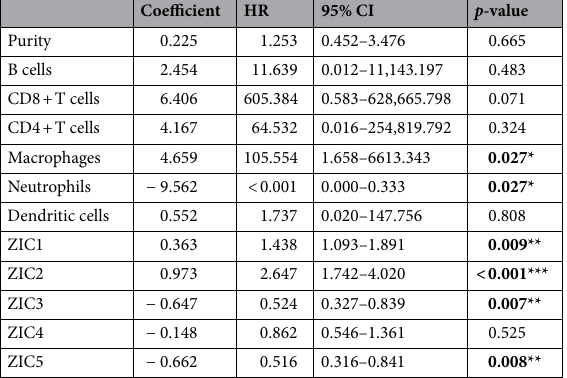
Table 3. Cox proportional hazards model factors related to survival, immune infiltrates and genes in LGG patients. HR hazard ration, 95% CI 95% confidential interval. * p < 0.05, ** p < 0.01, *** p < 0.001. Bold values indicate clinical